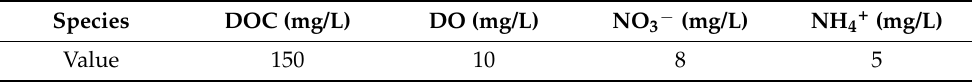
Table 4. The concentrations of the four species.